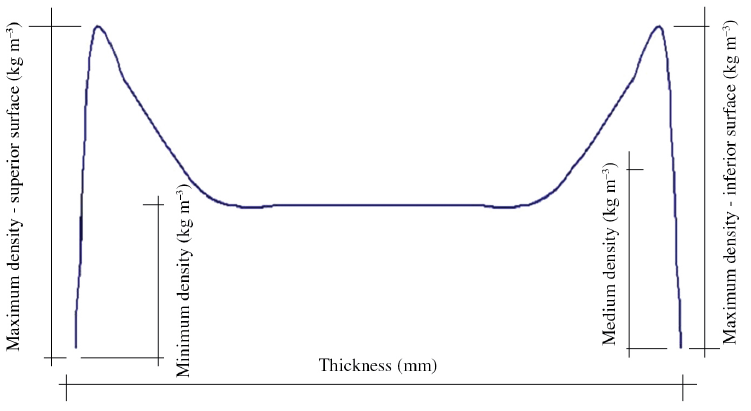
Figure 2. Quantitative parameters evaluated in the density